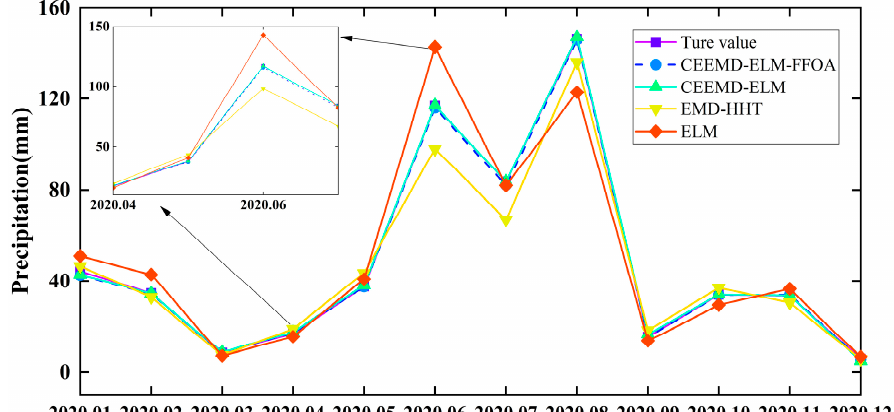
Figure 9. Prediction results of different models.